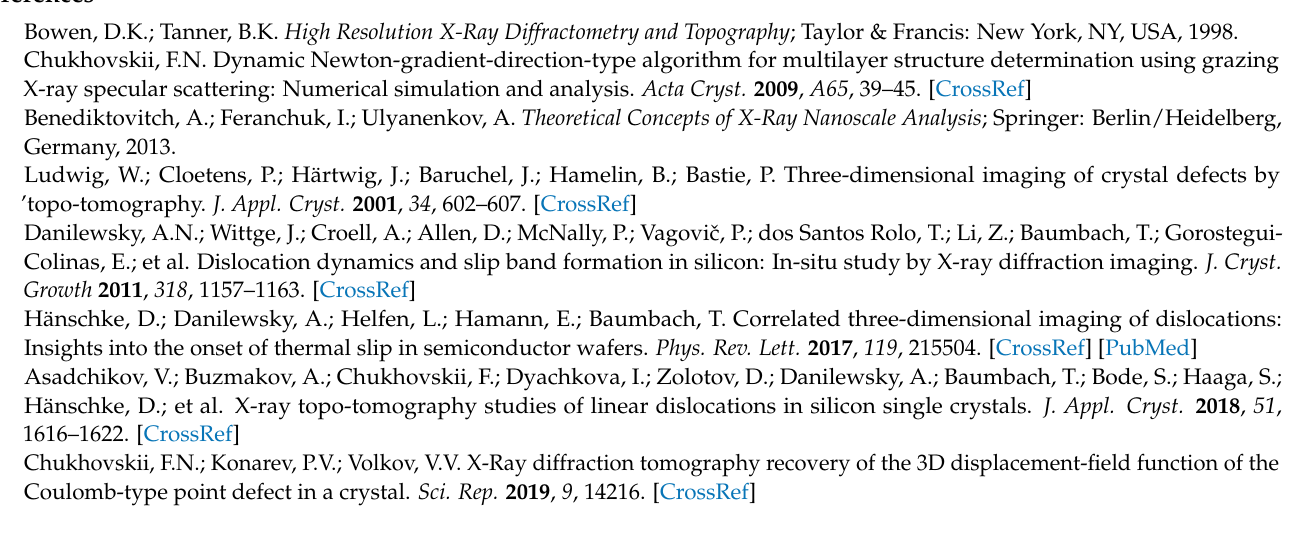
Figure 3. The 2D IPs: no- noise level (left), 4% -noise level (middle) and de-noised (right). The number of non-averaged IPs data frames is equal to 100. The sample rotation angles Φ are equal to {−20°, 0°, 20°}, respectively.